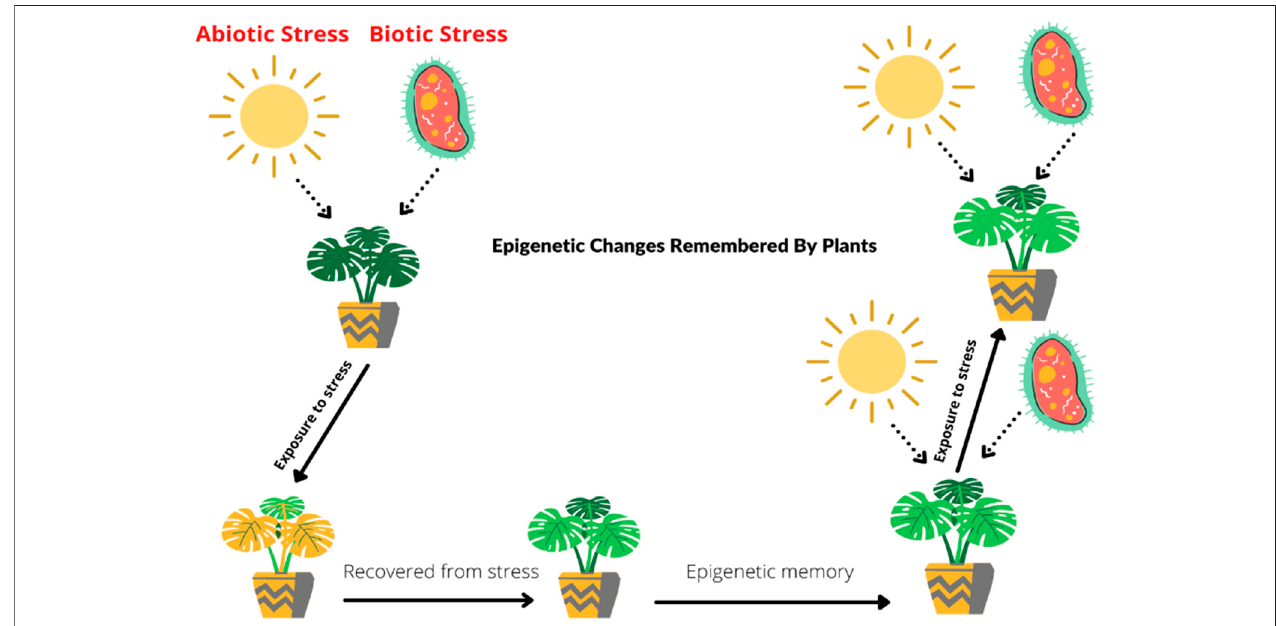
FIGURE1| Mechanisms underlying epigeneticmemoryin plantsduring stress.Plants ’ epigenetic memory helps protect themfrom differentstresses. Whenevera plant faces stress regardless of its biotic or abiotic nature, it starts recovery against stress, and the plant epigenetic stress memory stores that information. Due to this stored memory, stress does not affect the plant on subsequent